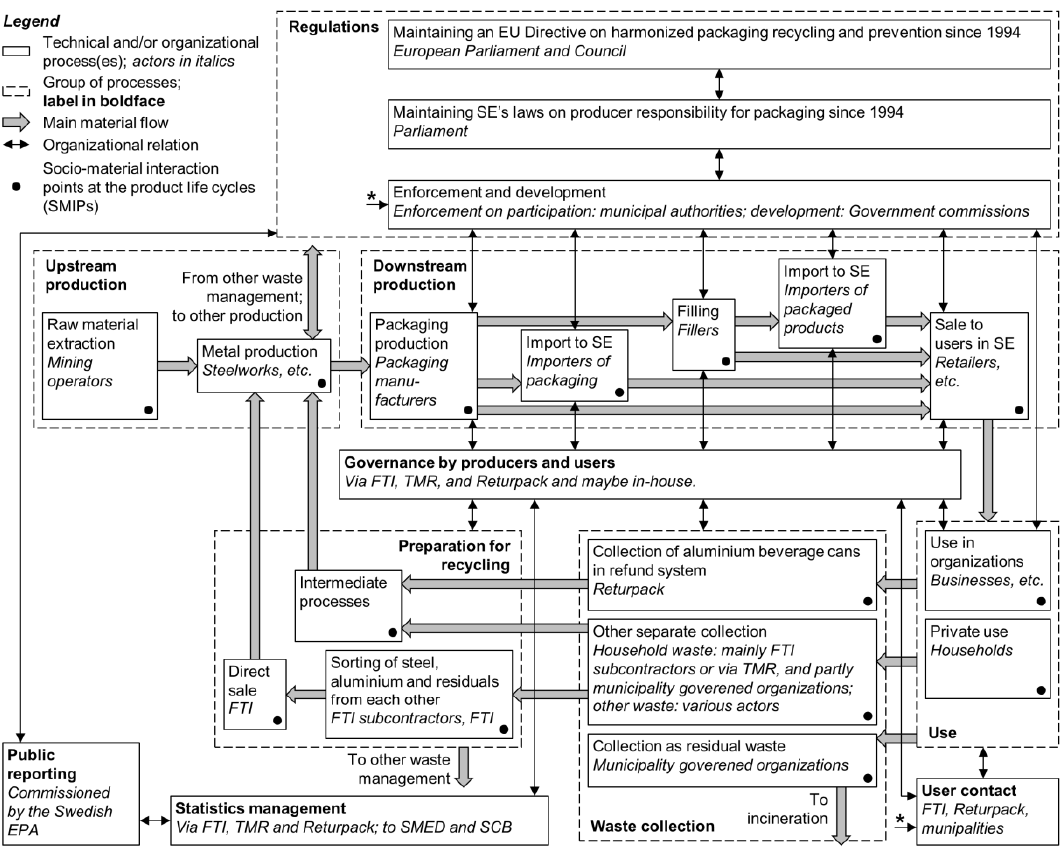
Figure 3. Central flows and organization in the Swedish metal packaging PCO, mainly for 2013–2017. * denotes the two ends of one organizational relation. EU = European Union, FTI = Förpacknings- och Tidningsinsamlingen, SCB = Statistics Sweden, SE = Sweden, SMED = Svenska MiljöEmissionsData, Swedish EPA = Swedish Environmental Protection Agency.